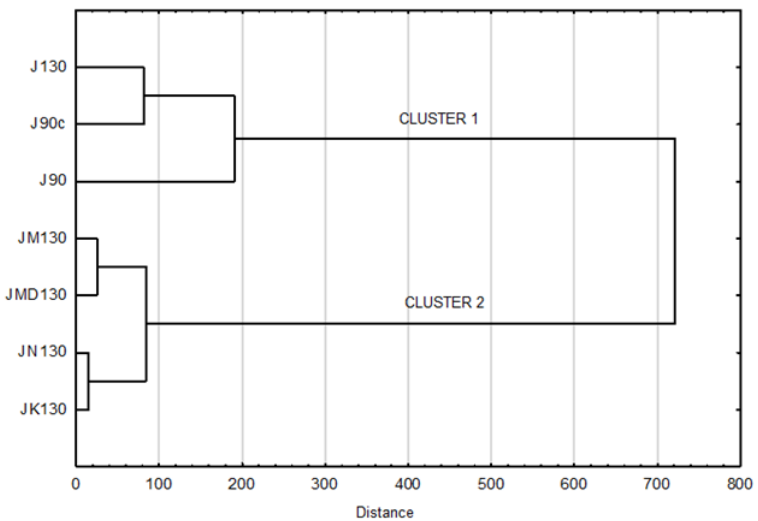
Figure 6. HCA classification of the powders based on color and betalain content.